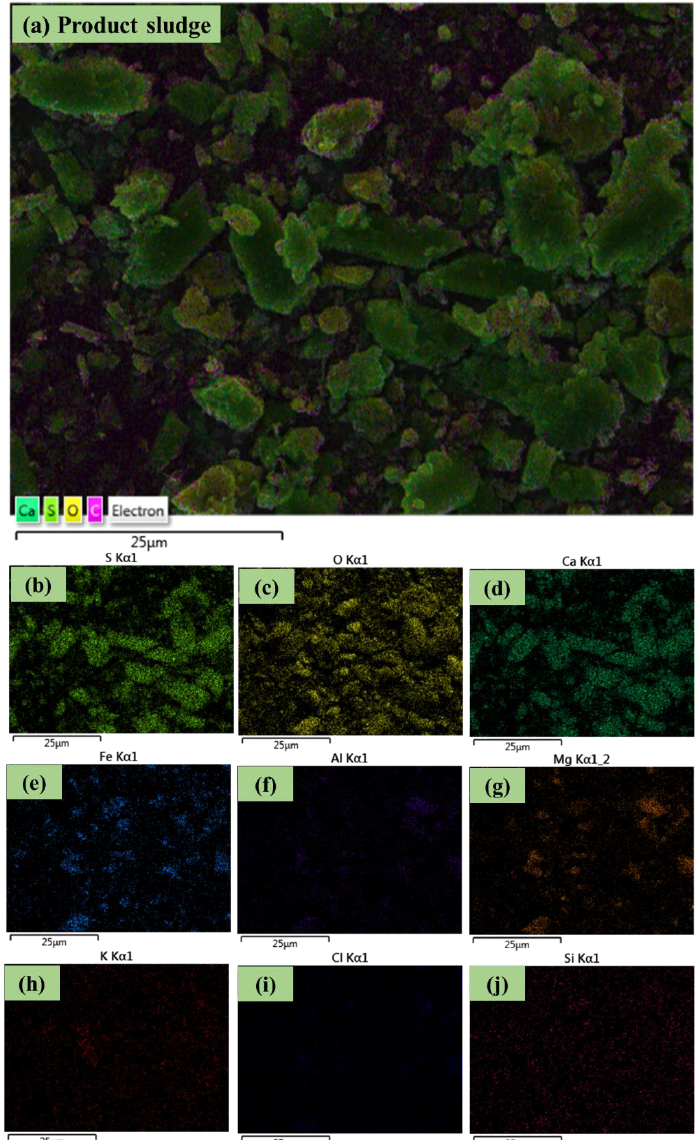
Figure 5. ( a ) The SEM-EDX micrograph of the product sludge and the elemental mapping of ( b ) S, ( c ) O, ( d ) Ca, ( e ) Fe, ( f ) Al, ( g ) Mg, ( h ) K, ( i ) Cl, and ( j ) Si. ( c ) O, ( d ) Ca, ( e ) Fe, ( f ) Al, ( g ) Mg, ( h ) K, ( i ) Cl, and ( j )